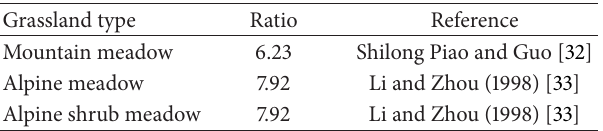
Table 1: Root:shoot ratio of the three representative grassland types.